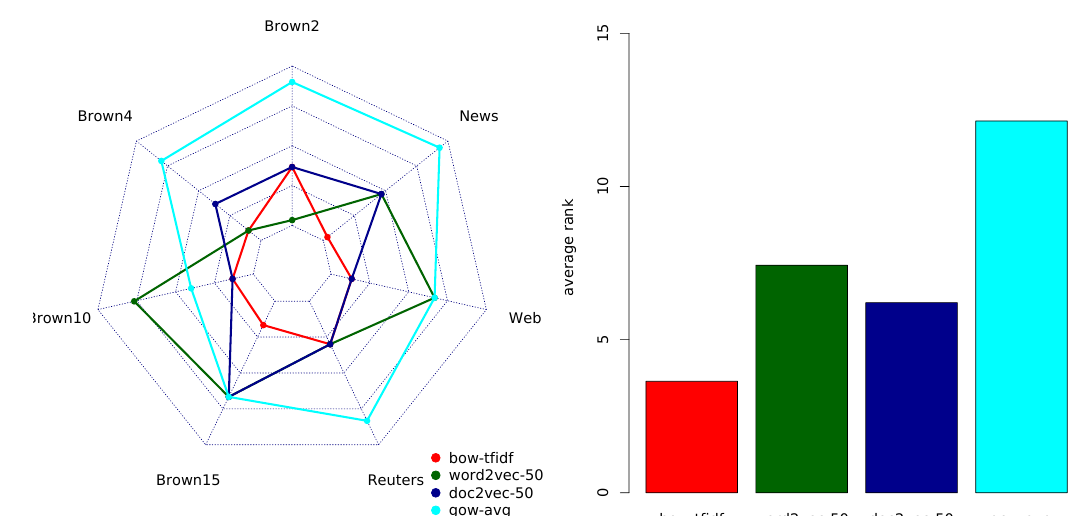
Figure A2. Radar-chart comparison of the multi-objective rankings by task ( left ) and their averages ( right ) for the four top-performing variants of the document representation models in each of the four groups with respect to